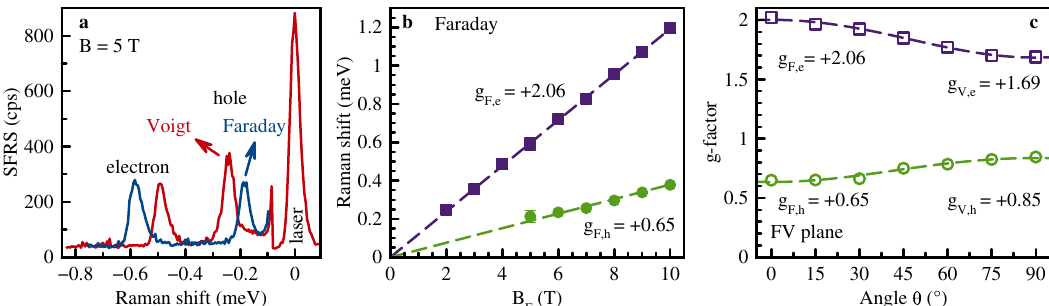
Fig. 3 Spin- fl ip Raman scattering of CsPbBr 3 . a SFRS spectra measured in the Faraday (blue) and Voigt (red) geometries at T = 1.6 K. The excitation/ detection polarization is σ − / σ + . Spectra are shown for the anti-Stokes spectral range where photoluminescence is suppressed. b Magnetic fi eld dependence of the electron (purple squares) and hole (green circles) Stokes Raman shifts. Lines are linear fi ts with g F,e = + 2.06 and g F,h = + 0.65. c Angular dependences of the electron and hole g -factors for the magnetic fi eld rotated in the Faraday-Voigt plane ( φ = 0 ∘ ). Lines are fi ts using Eq. (4). The sample c -axis is oriented perpendicular to k and parallel to the x-axis, c ∥ B , corresponding to the Voigt geometry ( θ = 90 ∘